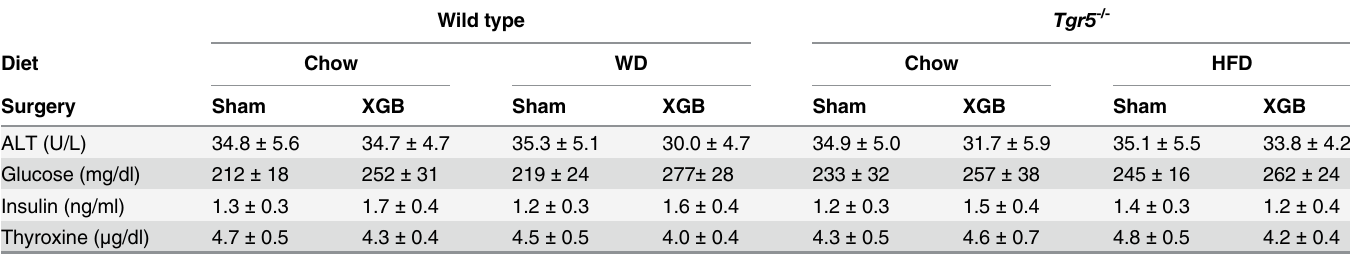
Table 1. Serum parameters in control and cholecystectomized mice.